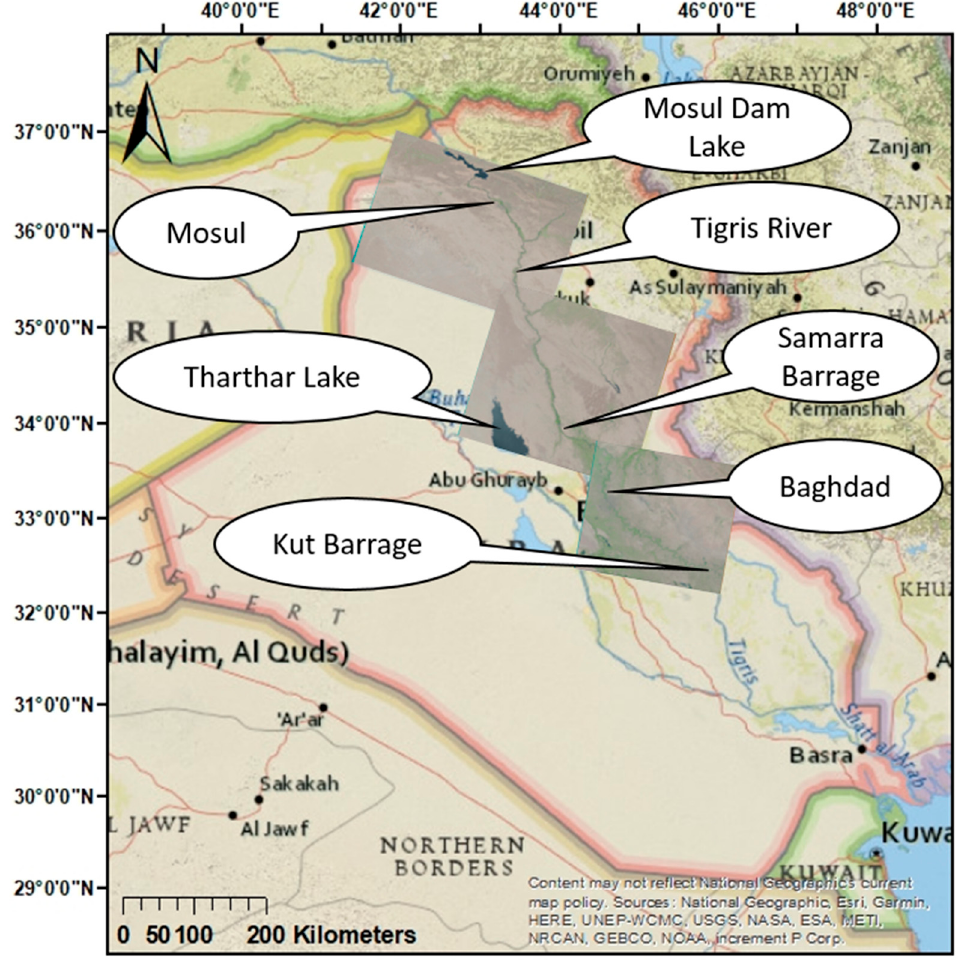
Figure 1. The Tigris River study area from Mosul Dam (River km 0) to Kut Barrage (River km 880).